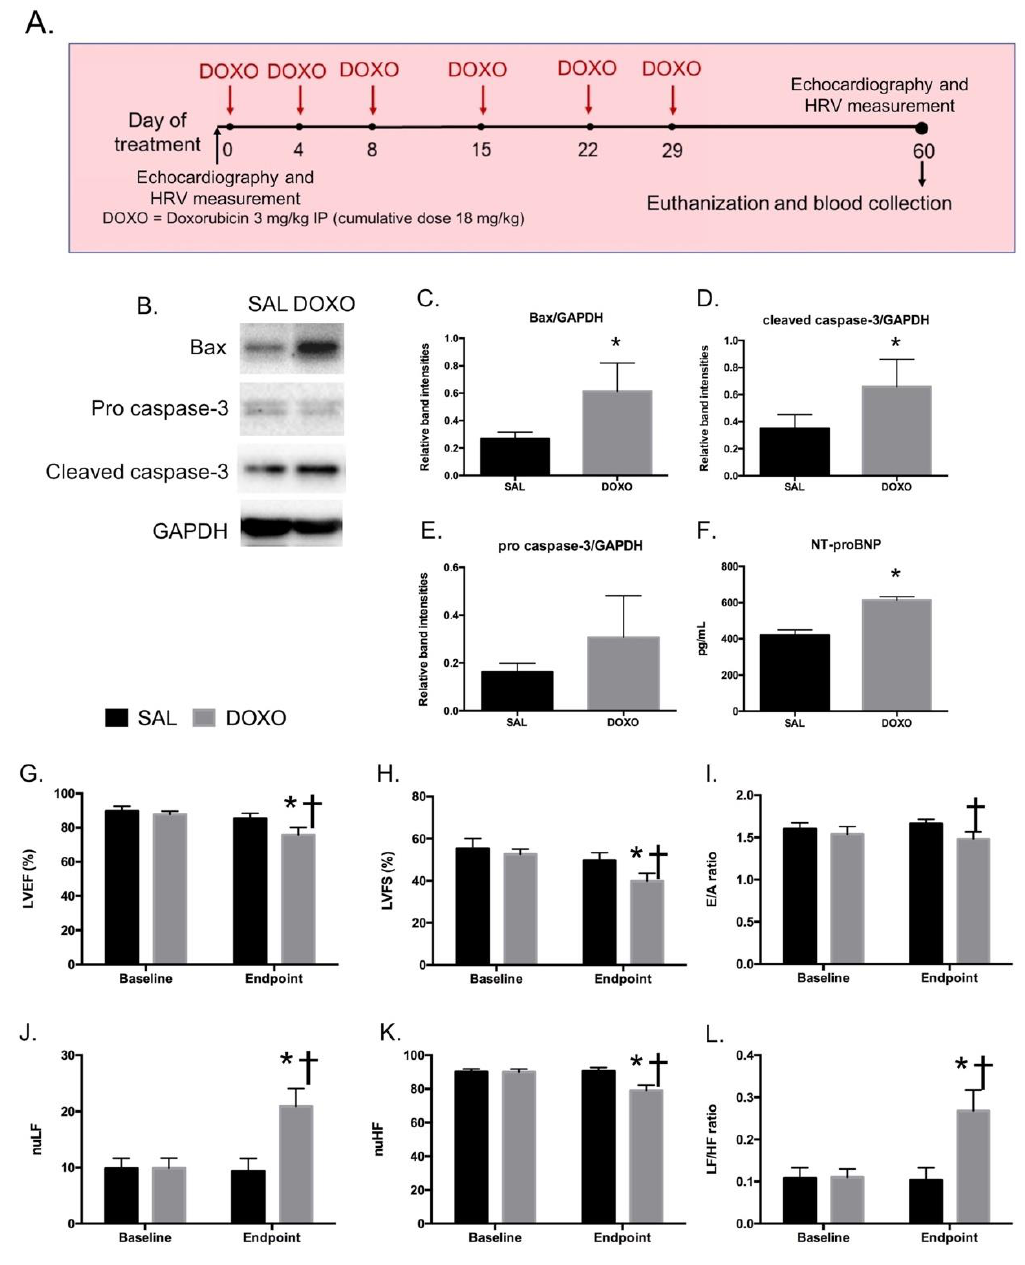
Figure 1. Timeline of DOXO treatment and blood collection in Wistar rats ( A ). Representative picture of Western blot of Bax, cleaved caspase-3, pro caspase-3, and GAPDH from heart tissues of saline- treated (SAL) and DOXO-treated (DOXO) rats ( B ). Fold change of band intensities of Bax relative